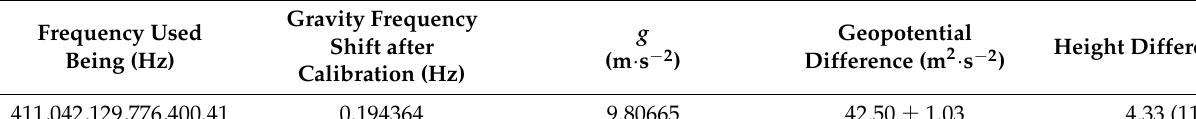
Figure 9. The Allan deviation of the frequency comparison series between two clocks. ( a ) at the same site; ( b ) at two different sites.